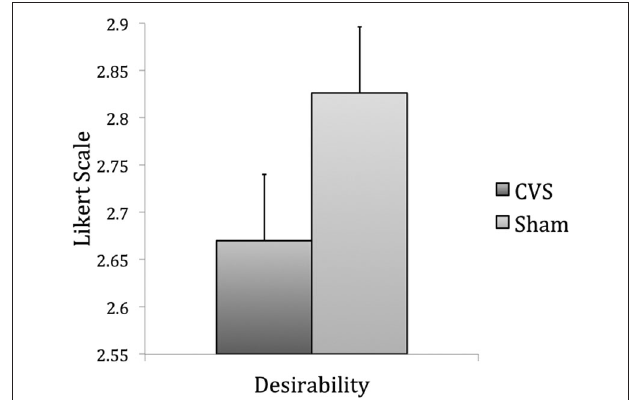
FIGURE 3 | Results of Experiment 2, item-based analysis: desirability of a product was lower during CVS than during sham stimulation ( p =